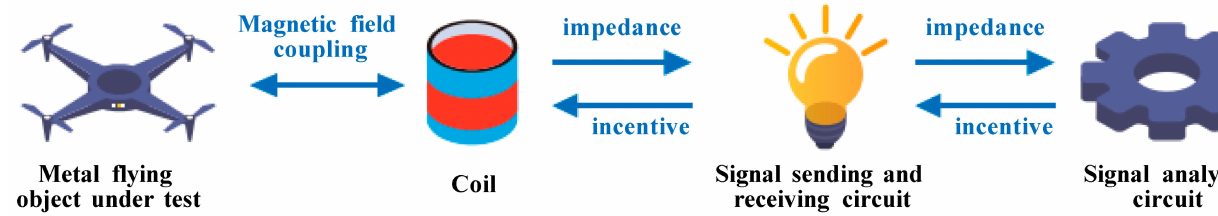
Figure 1. Schematic diagram of eddy current detection of metal flying